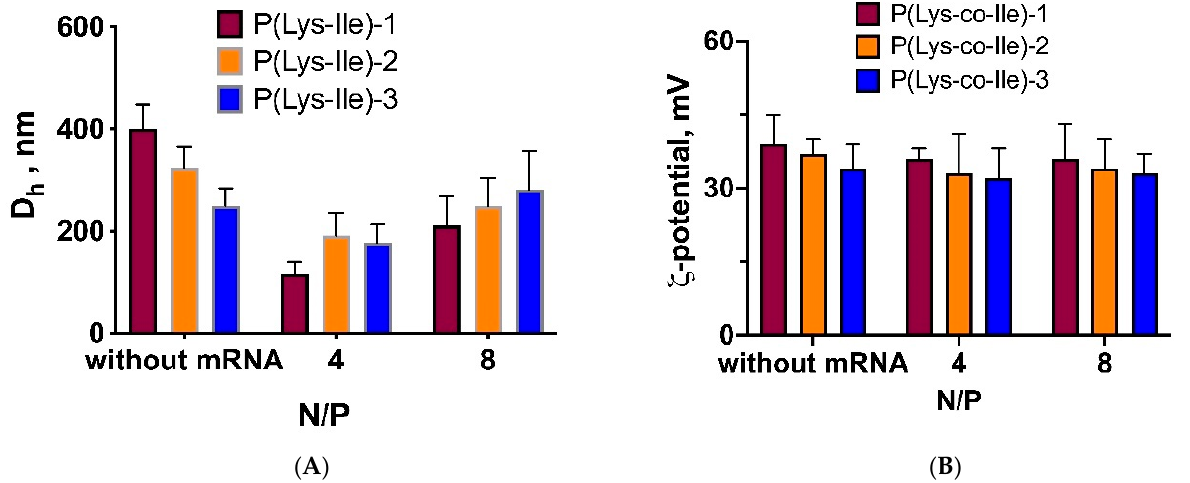
Figure 3. The effect of cationic polypeptide addition to mRNA/Ca 2+ at different proportions on size ( A ) and ζ -potential ( B ) of formed polyplexes. The presented data were obtained for P(Lys-co-Ile)-3 copolymer. The measurements were performed in ultrapure H 2 O. Results are given as Mean ± SD ( n = 3).